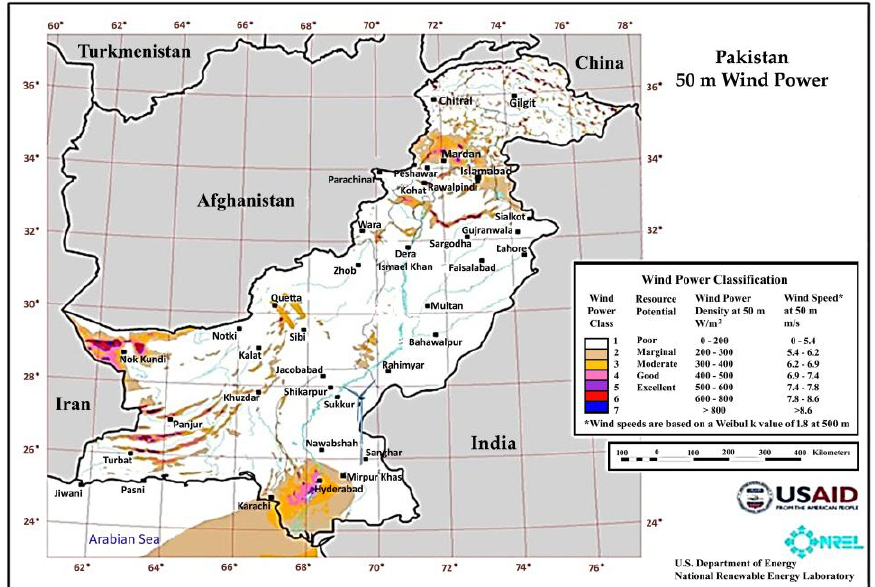
Figure 4. Wind map of Pakistan showing all provinces (for interpretation of the references to color in this figure, the reader is referred to the web version of this article [13].